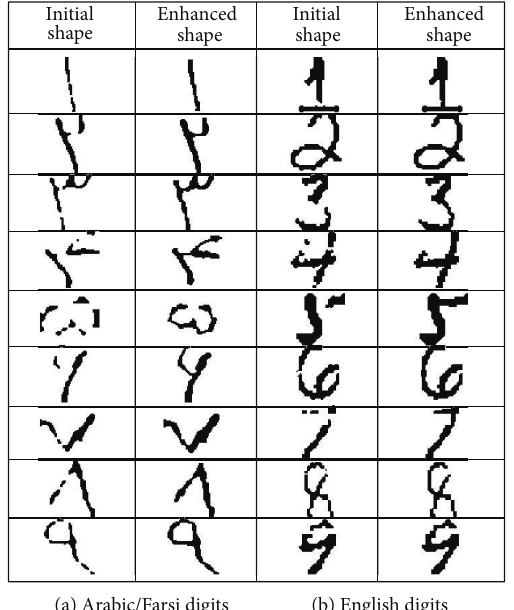
Figure 2: Applying proposed connecting procedure on input